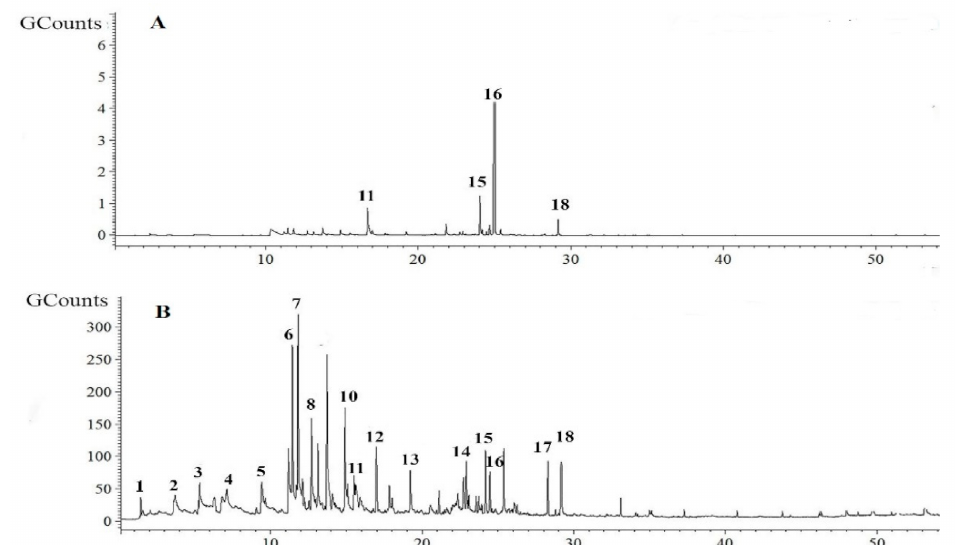
Figure 3. The GC chromatogram of the possible GBSC56 volatiles was identified through GC-MS analysis. Similar VOCs in the control are excluded. ( A ) The chromatograph of VOCs produced in Control. ( B ) The VOCs produced by GBSC56. The VOCs were selected in a time duration of 0–30 min. The numbering represents peaks for different VOCs. The pure possible VOCs identified are (1) cyclopentene (CP), (2) dimethyl disulfide (DMDS), (3) methyl isovalerate (MIV), (4) butanoic acid, 3-methyl, ethyl ester (BMEE), (5) ethyl tiglate (ET), (6) ethyl-2-methyl butyrate (EMB), (7) 2- methylheptonic acid (MHA), (8) octanoic acid 2-methyl (OAM), (14) 2-undecanone (2-UD), (17) pentadecane (PD).